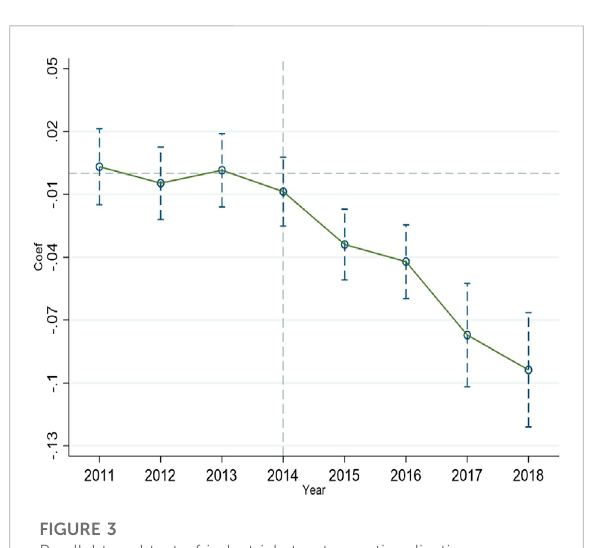
FIGURE 3 Parallel trend test of industrial structure